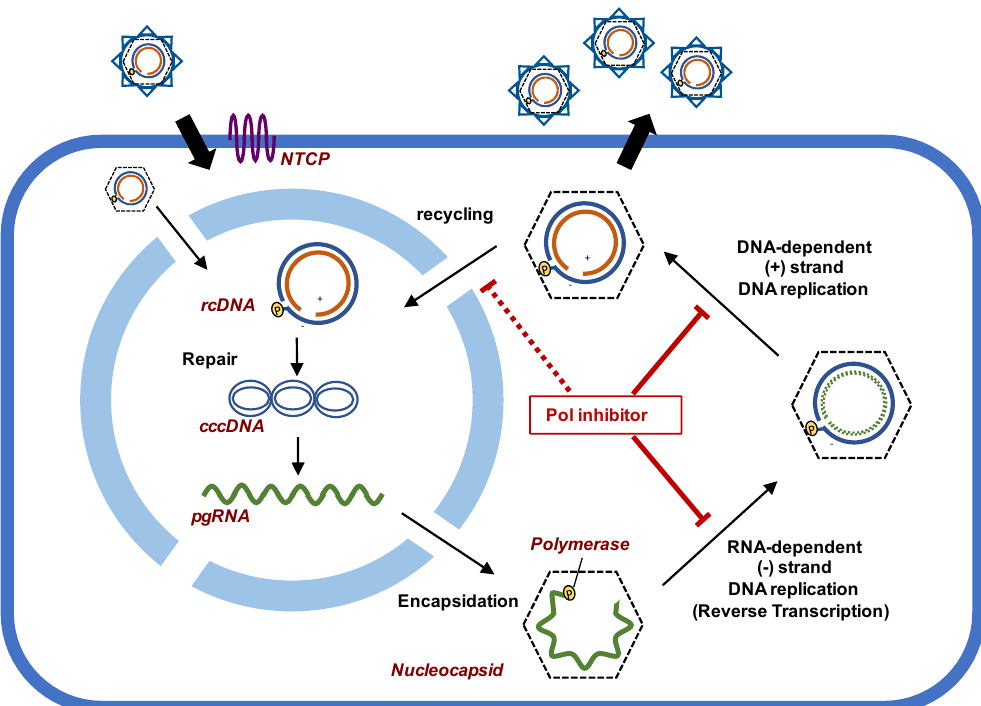
Figure 1. The lifecycle of hepatitis B virus (HBV) focusing on viral genome replication. HBV polymerase has several crucial roles in viral replication. Polymerase inhibitors block the reverse transcription pathway, namely RNA-dependent minus- strand DNA synthesis; they also block DNA-dependent plus-strand DNA synthesis, thereby suppressing the recycling step for cccDNA